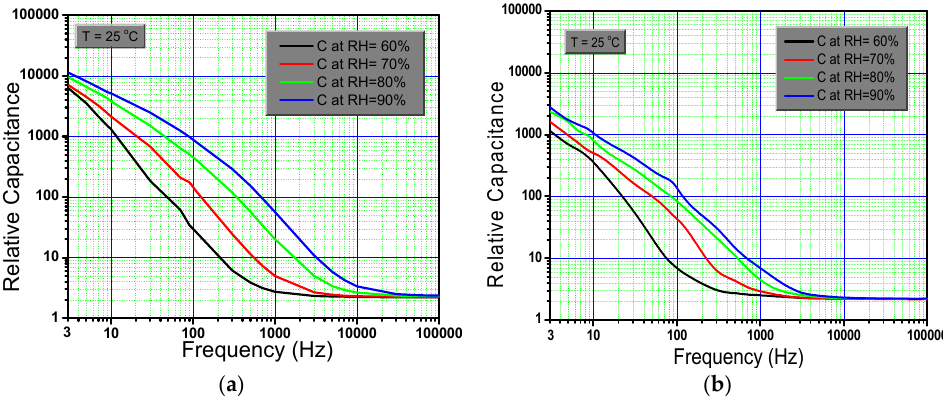
Figure 3. The capacitance variation of the sensors (as a function of humidity at varied frequencies) with ( a ) interdigitated and ( b ) rectangular (Ag) electrodes configuration respectively.